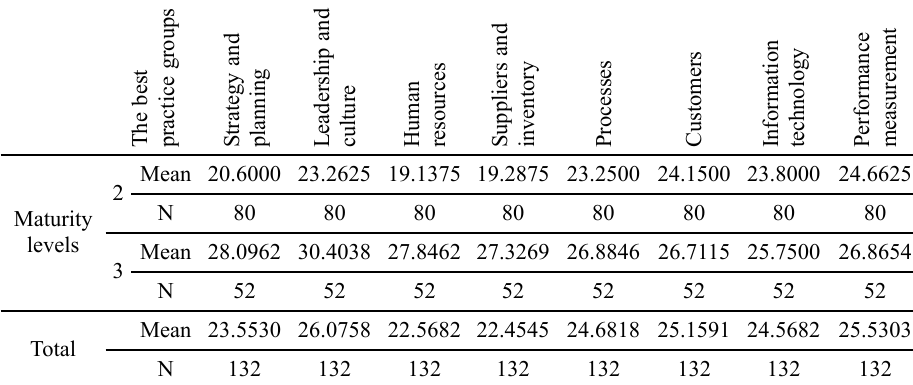
Table 6. Average values of the best practices groups for the enterprises by maturity levels